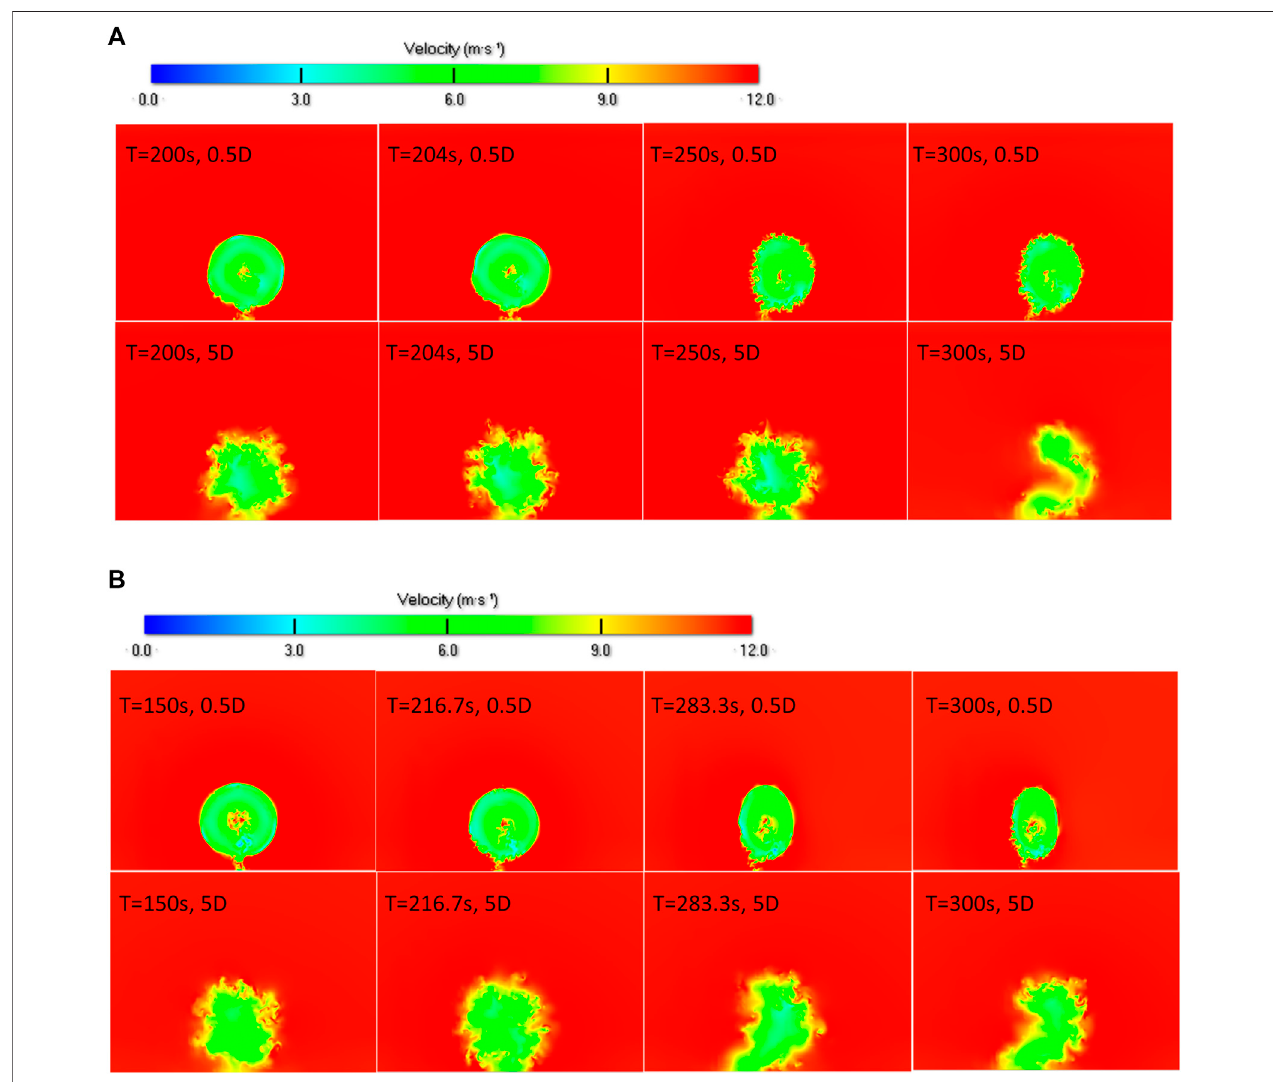
FIGURE13| Theinstantaneousvelocitycontoursofthewakecross-sectionat0.5Dand5Dbehindtheturbinerotor: (A) rapiddynamicyaw; (B) slowdynamicyaw.